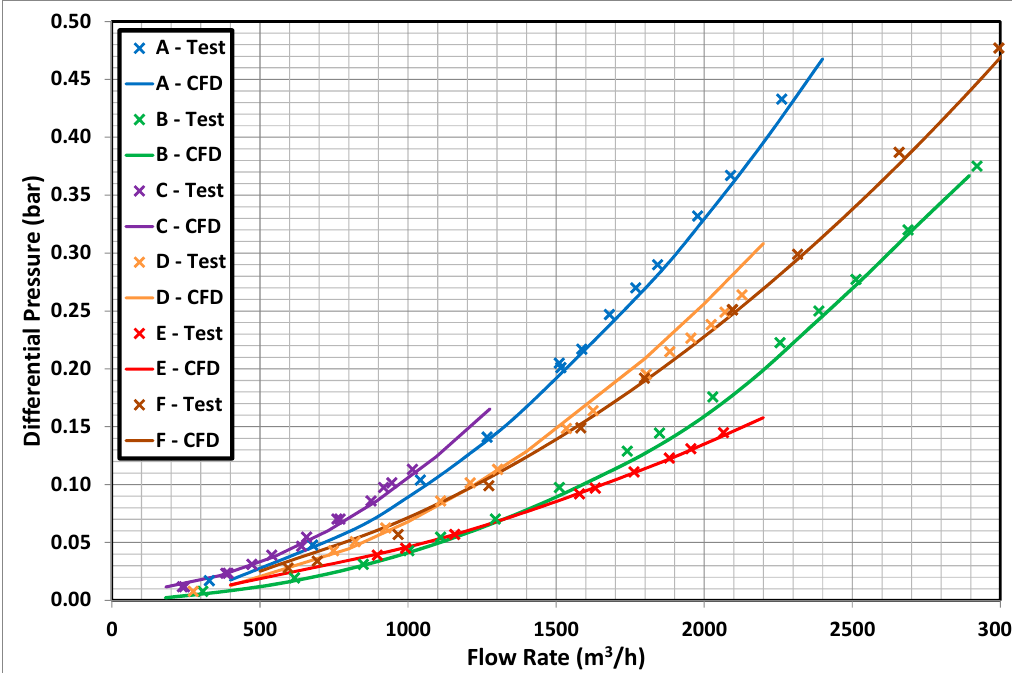
Figure 10. Comparison between laboratory tests and CFD simulations of six different models of air valve. Air expulsion flow.